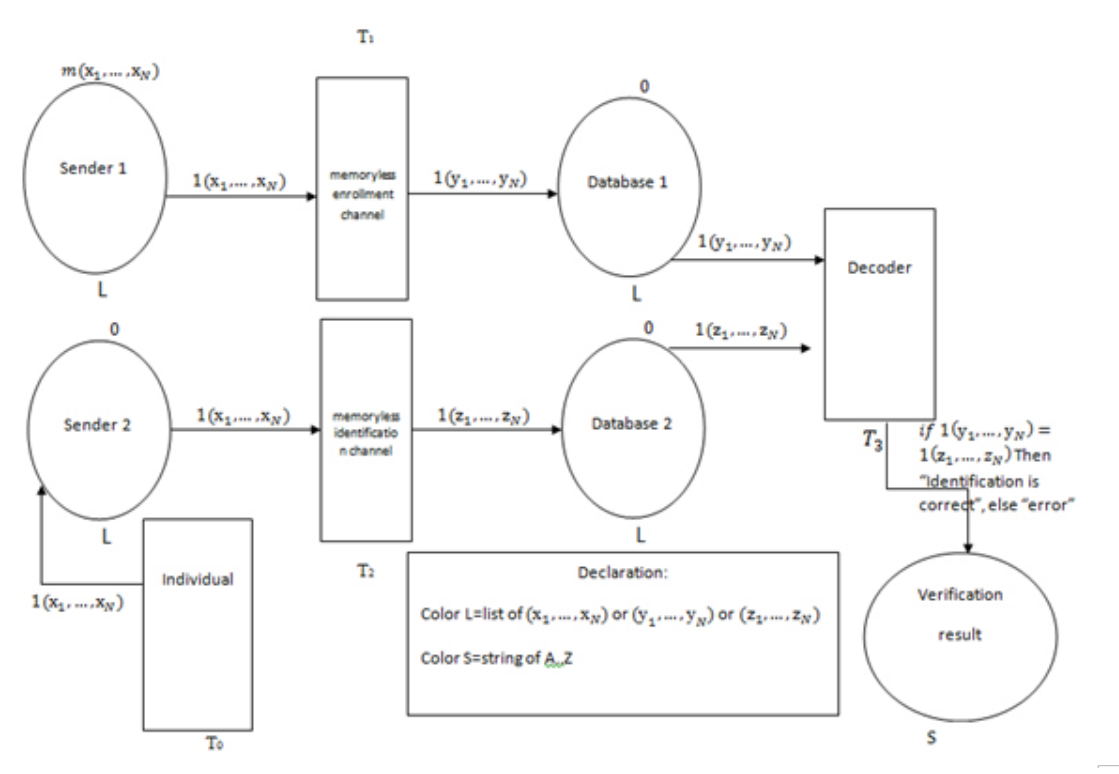
Fig.4 The model of biometric identification system by Colored Petri